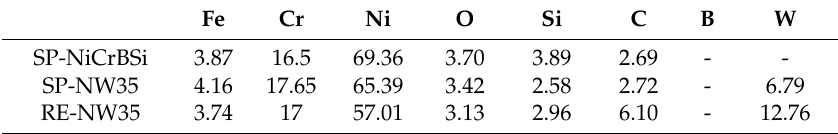
Table 3. Chemical Compositions of Worn Surfaces in the Dash Rectangles in Figure 7 (wt.%). Fe